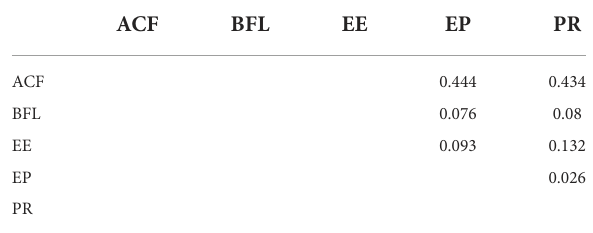
TABLE 5 Effect size